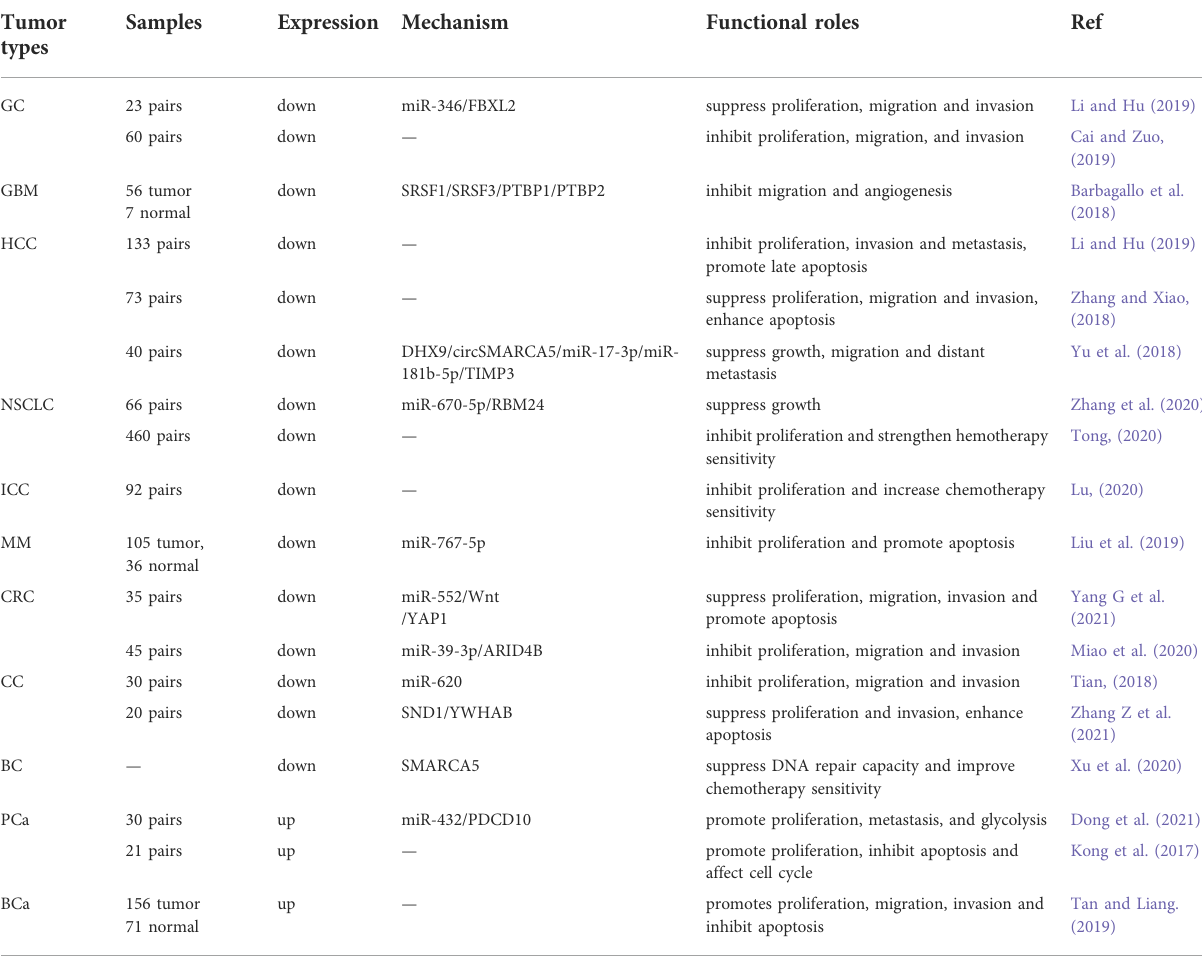
TABLE 1 The expression and roles of circSMARCA5 in various cancers. Tumor types